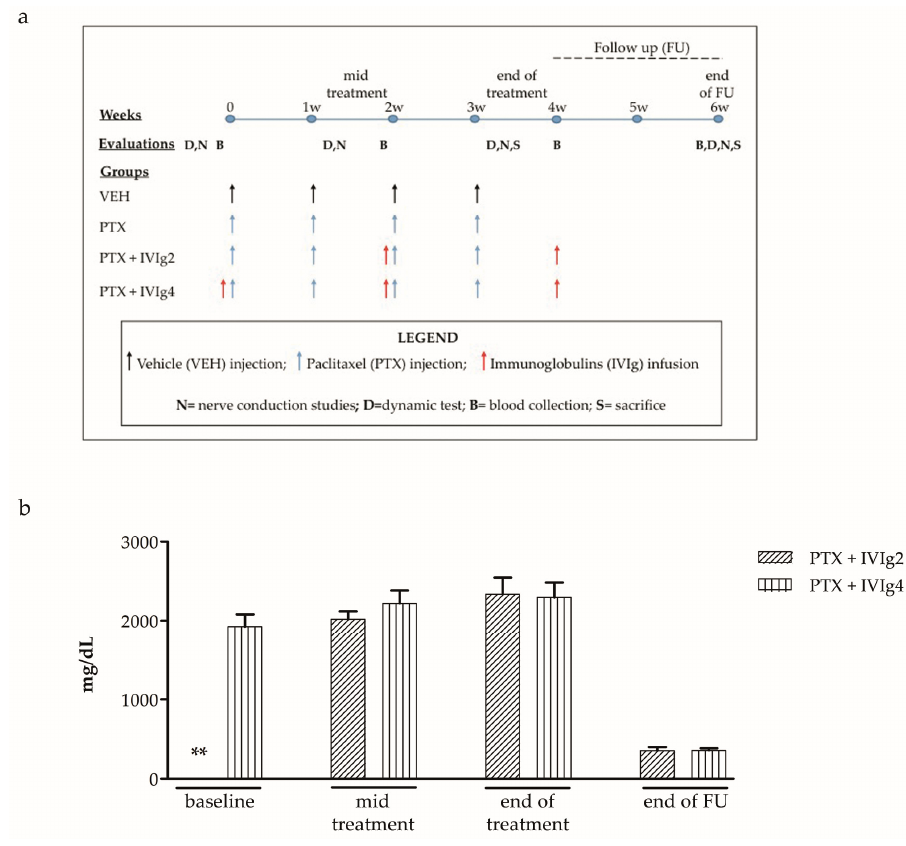
Figure 1. Flow chart and serum concentration of human intravenous immunoglobulin (IVIg). ( a ) Flow chart of the experimental plan. ( b ) At baseline, mid treatment and at the end of treatment blood samples were collected 1 h after IVIg infusion. At follow up, blood samples were collected two weeks after the last IVIg infusion. ** infusion with IVIg not performed as per the protocol.